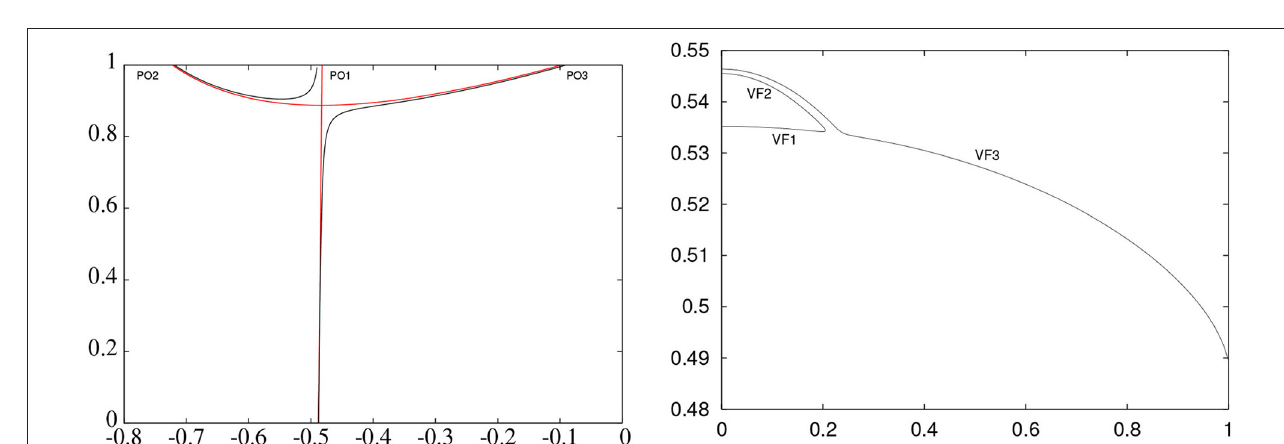
FIGURE 3 | Left: Continuation of L 4 as a periodic orbit with respect to the mass of Sun. Horizontal axis: x . Vertical axis: ε . The black curve stands for the continuation to the BCP. The red curve for the truncated version of the BCP. See text for more details. Right: Vertical families of 2 D tori for the BCP. The horizontal axis is the p z coordinate and the vertical axis displays the frequency. See text for more details.